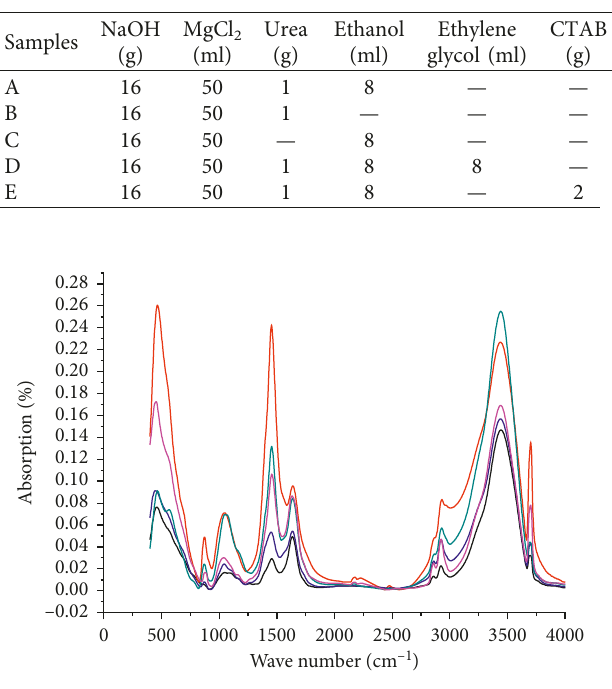
Table 1: Start materials for preparation of the samples.